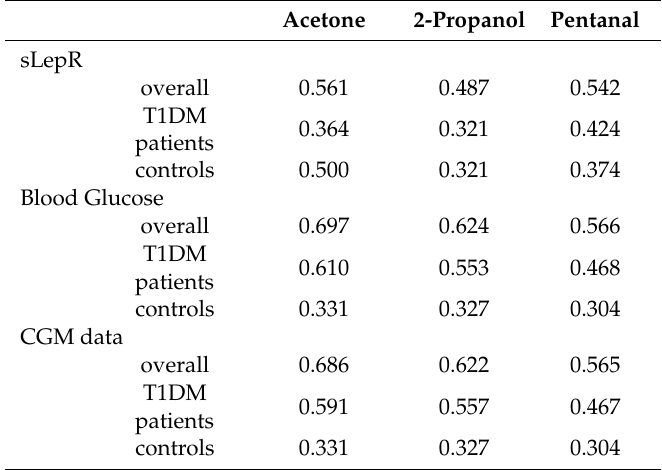
Table 4. Pearson product correlation coe ffi cients between distinct VOCs and CGM as well as serum parameters (each p < 0.001). Detailed data are given in Supplementary Tables S3 and